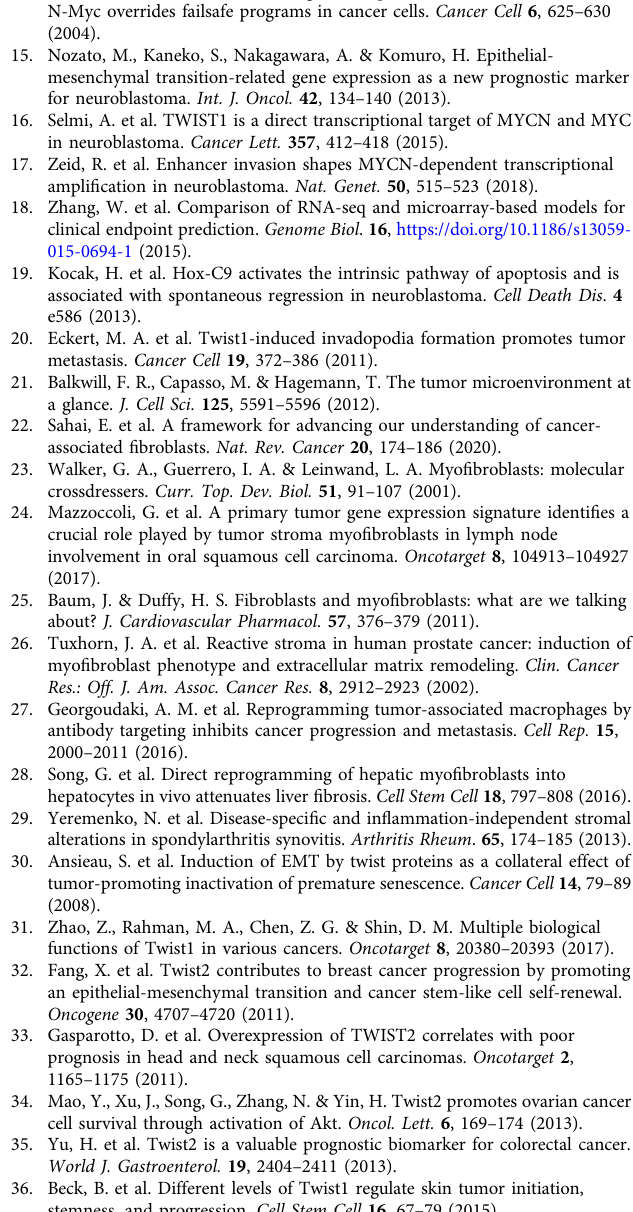
Fig. 8 Identi fi cation of a TWIST1-associated myo fi broblast signature and PPI network for the TWIST1-associated tumor-stroma signature and the DE stromal genes. a Volcano plots showing the distribution of the DE gene identi fi ed in SK-N-Be2c-Control and – sgTWIST1 tumor stroma of ortho_1 xenografts relative to their log2(FC) and adjusted p value (FDR). Genes with FDR < 0.05 and absolute value (av) of log2(FC) ≥ 0.5 were considered as DE. Genes identi fi ed as the Myo fi broblast signature are indicated in red ( n = 36). The green square is for the gene Marco . b Bar graph showing the biological processes, cellular components, and REACTOME pathways identi fi ed by GO analysis of the 89 DE genes of the murine stroma, listed according to their adjusted p value. c mRNA expression levels of the selected myo fi broblast genes and Marco relative to Actb as by RT-qPCR. Data are plotted as individual values with mean ± SD. Mann − Whitney test: * p = 0.0286. Ortho_1 Control and sgTWIST1 tumors: n = 4. d IHC for the cancer-associated fi broblast marker Fibroblasts Activation Protein (FAP) on ortho_1 Control and sgTWIST1 tumors. Representative images of FAP positive cells characterized by spindle or fusiform morphologies and haphazardly arranged are shown (400×, scale bar: 20 µ m). e Analysis of the protein − protein interactions between the TWIST1-tumor stroma signature ( n = 77 genes) and the DE murine stromal genes ( n = 89). Direct (physical) as well as indirect (functional) interactions analyzed using the String website. All the basic and advanced default settings have been kept but the minimum required interaction score, that has been changed in high con fi dence (0.7); and the network display options, hiding the disconnected nodes in the network. PPI enrichment p value: <1.0 e − 16 . Murine stromal genes clustering with the TWIST1 tumor-stroma signature are underlined in